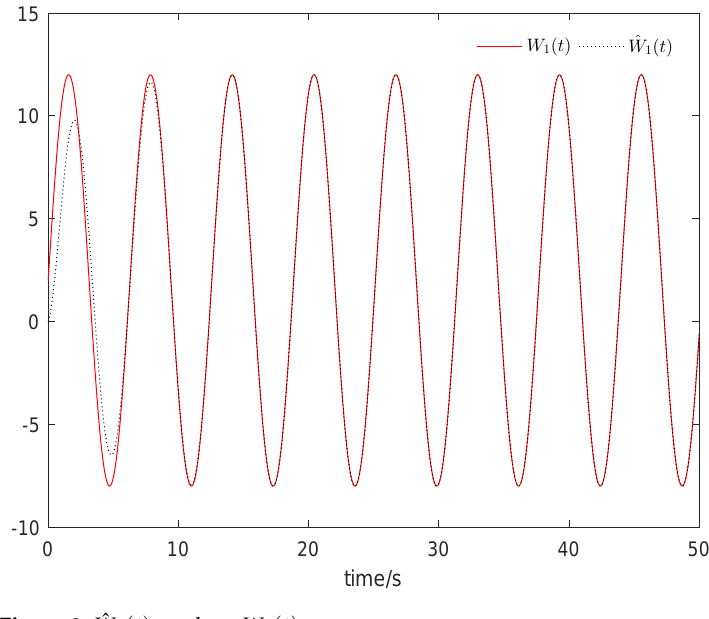
Figure 3. ˆ W 1 ( t ) tends to W 1 ( t ) .